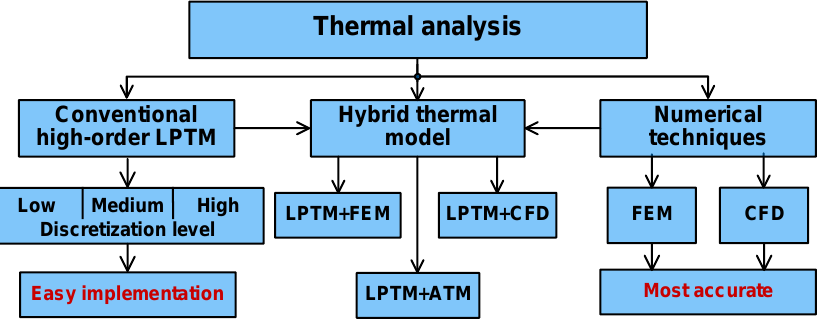
Figure 14. Main thermal analysis methods.